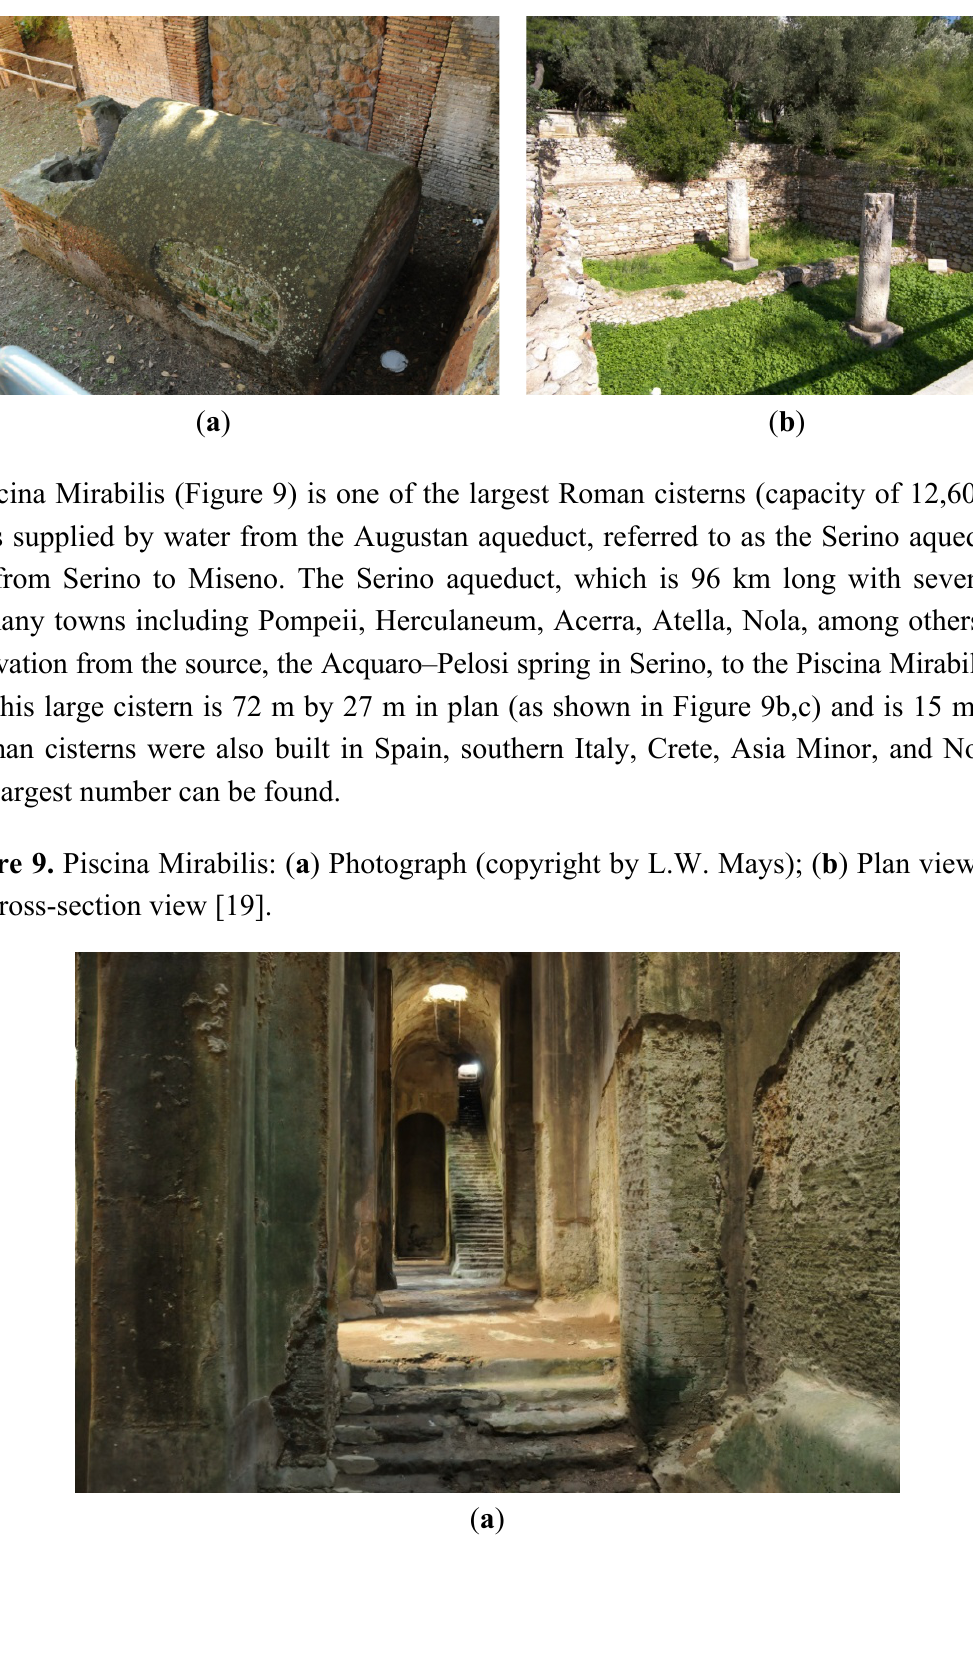
Figure 8. Comparison of Roman cisterns: ( a ) Small cistern in Ostica Antica and ( b ) Much larger cistern below the Acropolis of Athens (photo copyright by L.W. Mays).